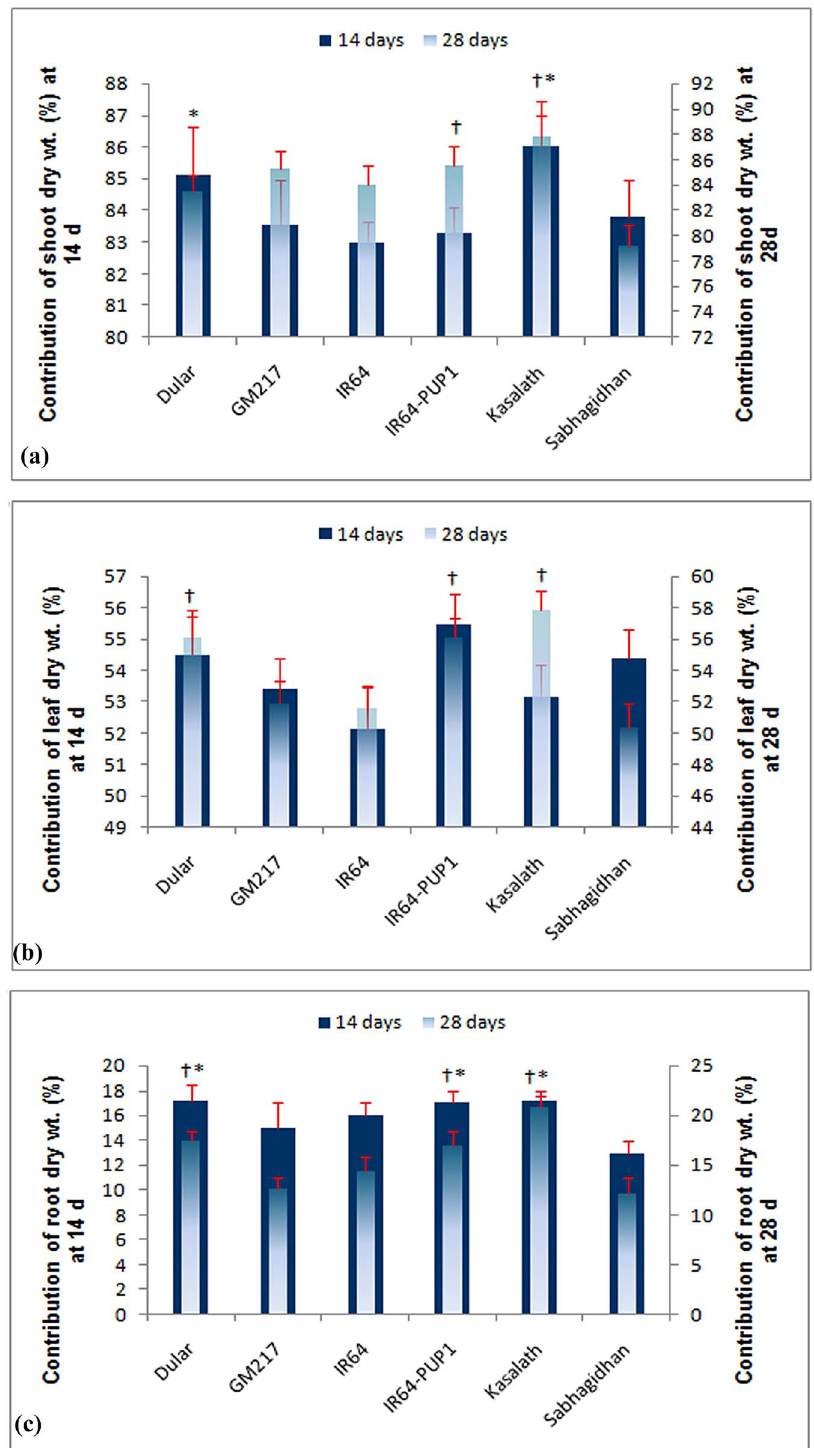
Figure 6. Percentage contribution of shoot/leaf/root dry weight in the total plant weight of genotypes across a different concentration of phosphorus in the hydroponic experiment at 14 d and 28 d. Vertical bars represent standard deviation. * p = 0.05 at 14 d, † p = 0.05 at 28